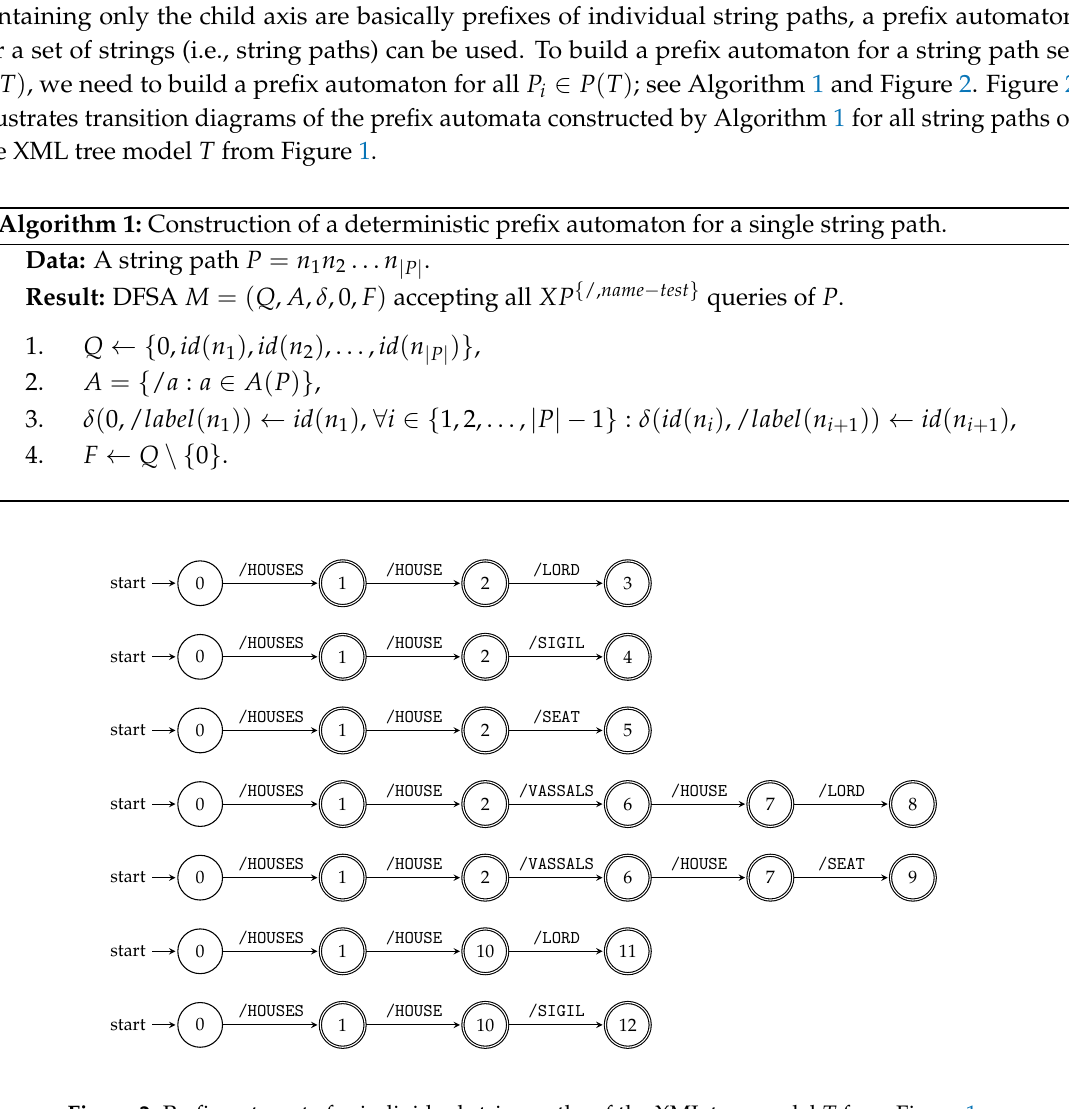
Figure 2. Prefix automata for individual string paths of the XML tree model T from Figure